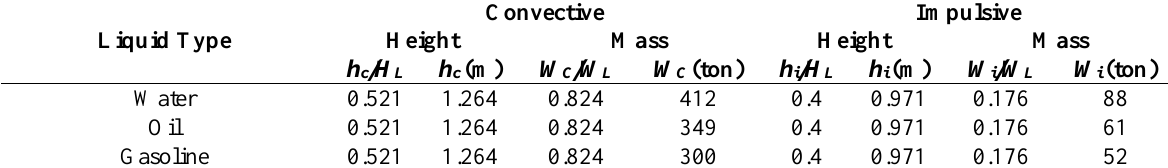
Table 8. Comparing of impulsive and convective parameters